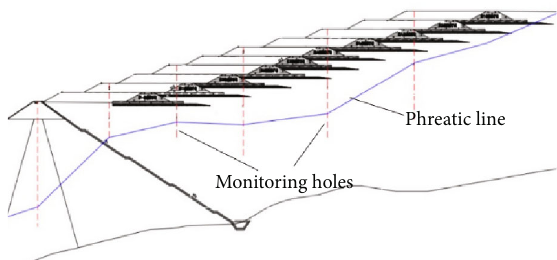
Figure 10: Monitoring hole and buried depth of the dam in fi ltration